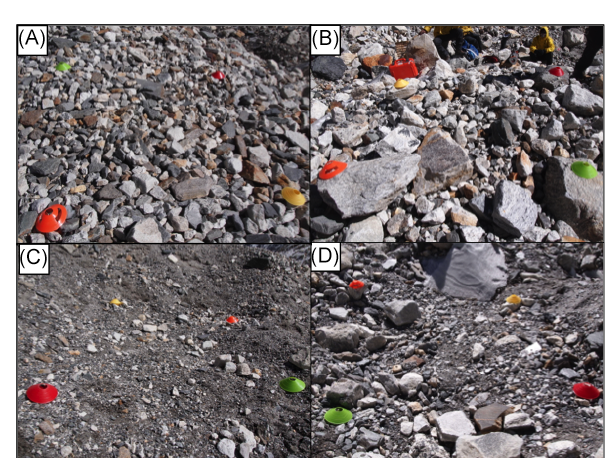
Figure 2. Sites A–D highlighting the variations in grain sizes that are found over the debris-covered portion of Imja–Lhotse Shar Glacier (cones 0.19m